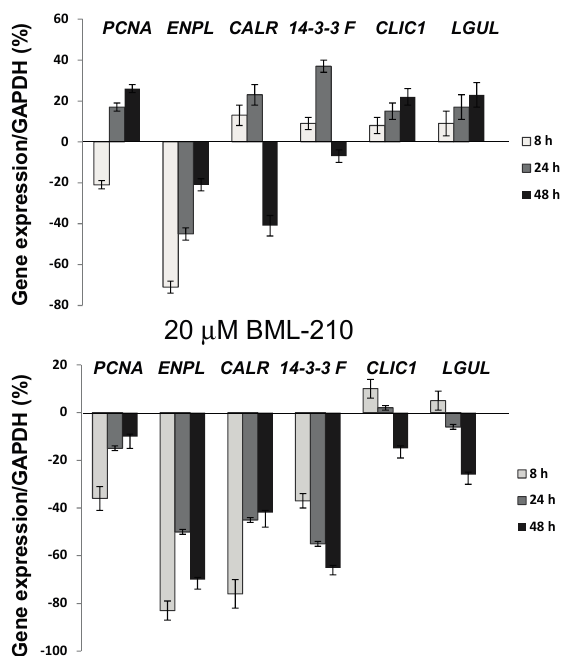
Figure 4. Changes of PCNA , ENPL , CALR , 1433F , CLIC1 and LGUL during treatment with BML-210. Cells were exposed to 10 or 20 µM of BML-210 for two days. The expression levels of PCNA , ENPL , CALR , 1433F , CLIC1 and LGUL were determined by RT-PCR analysis. The results presented as % from control cells (untreated). Results are given as mean ± S.E.M. ( n =